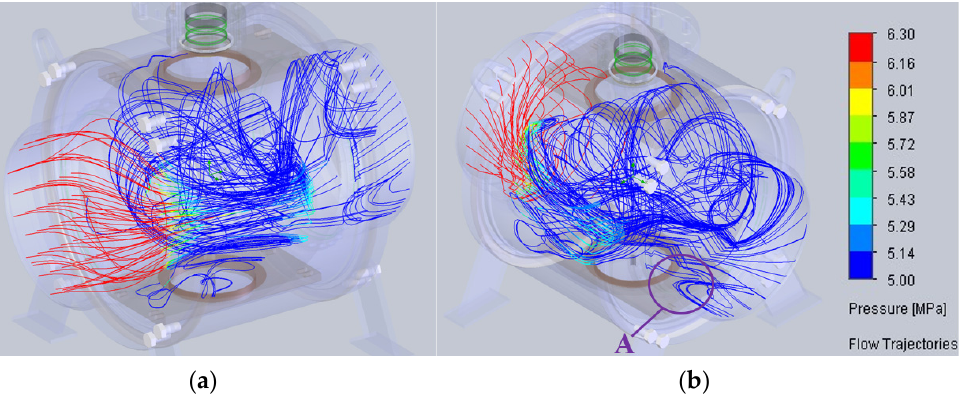
Figure 10. Pressure line trajectories for a 70° closure angle: ( a ) upstream view; ( b ) downstream view.